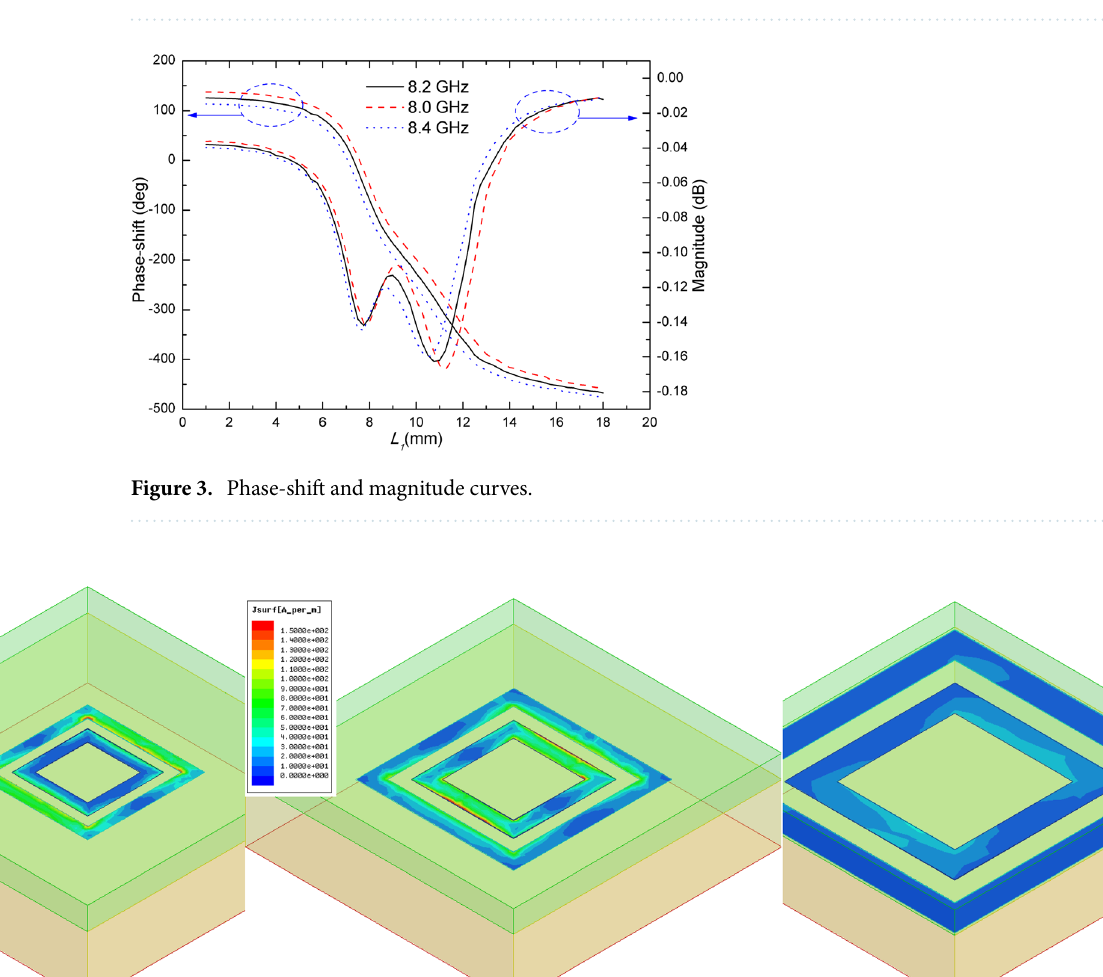
Figure 2. The structural details of the double square ring element.